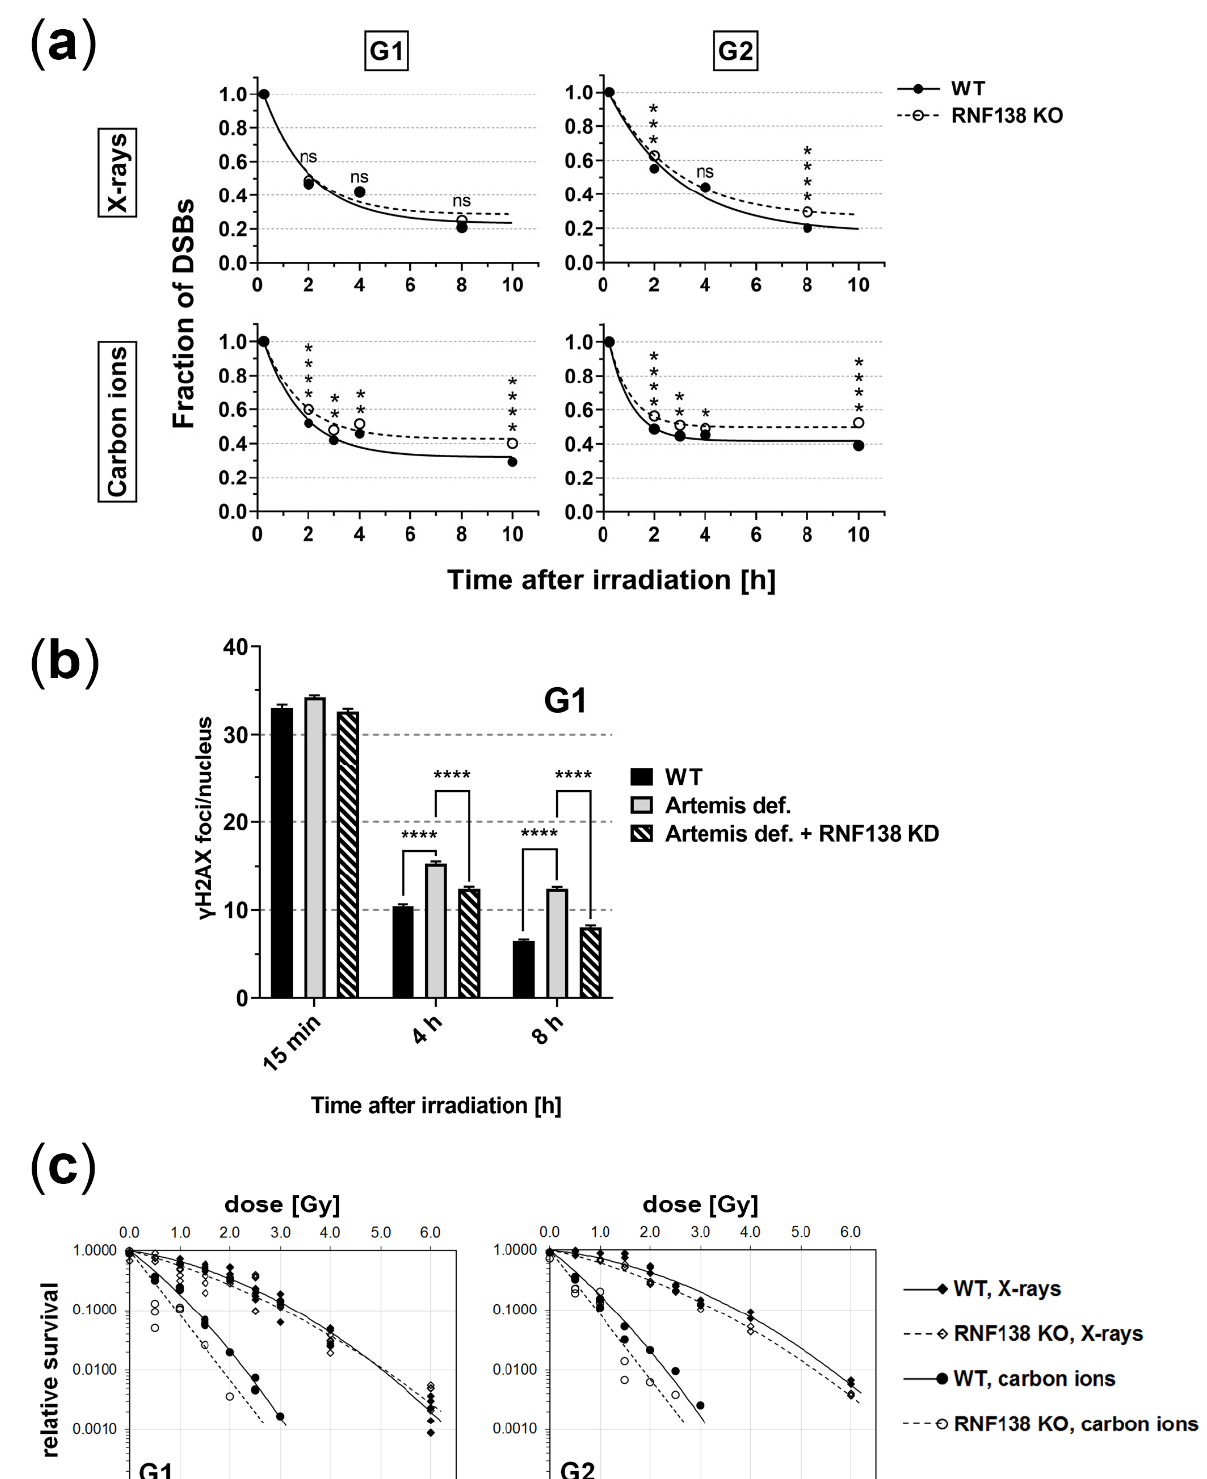
Figure 7. RNF138 deficiency diminishes DSB repair and survival of heavy-ion-irradiated cells. ( a ) U2OS cells, RNF138 proficient (wt) or deficient (RNF138 KO), were irradiated with 1 Gy X-rays